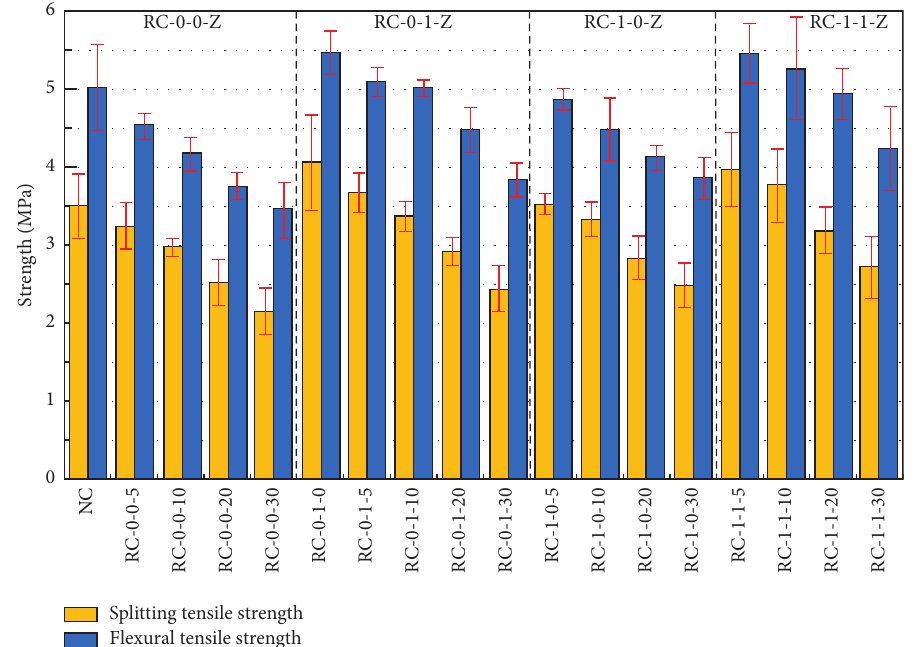
Figure 10: 28d splitting tensile strength and flexural tensile